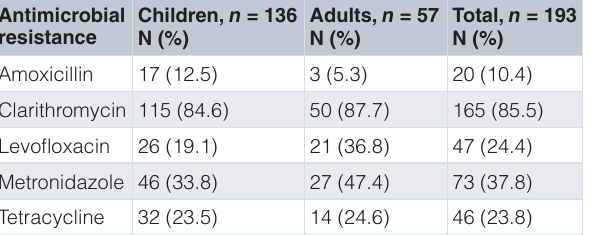
Table 1. Prevalence of antimicrobial resistance in Helicobacter pylori isolates. Antimicrobial resistance